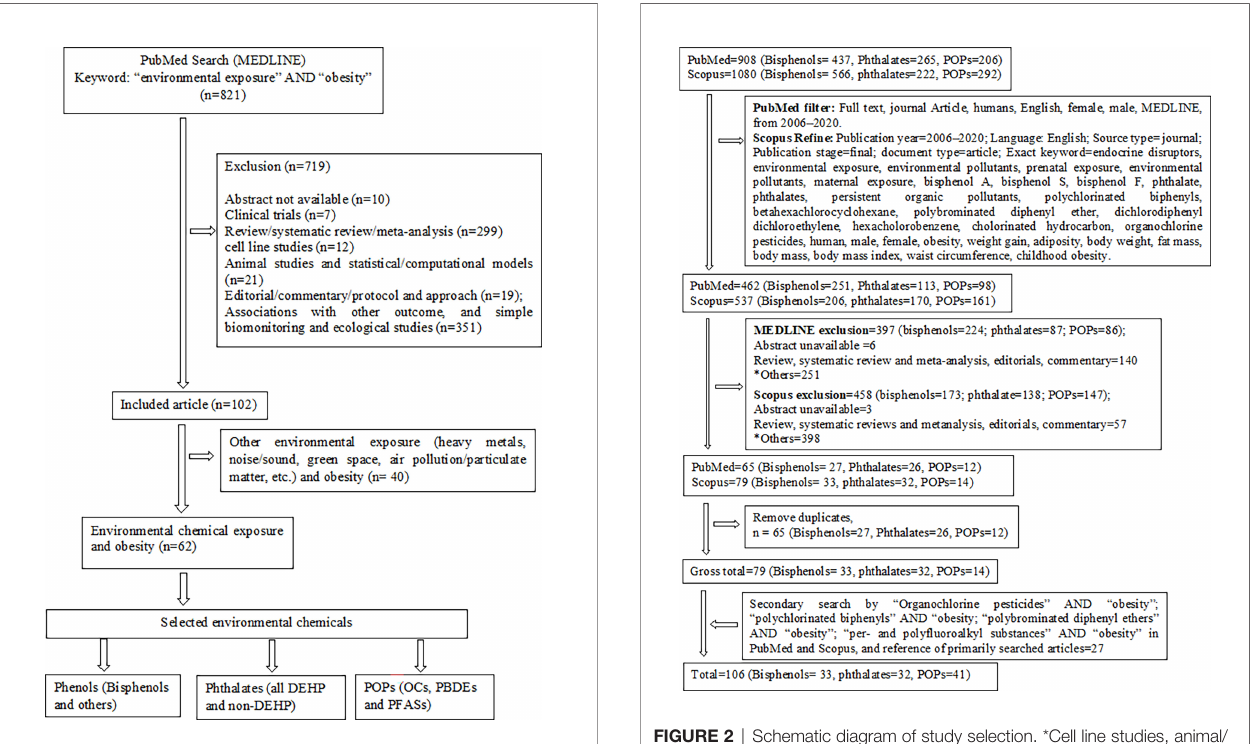
FIGURE 1 | Schematic diagram of the strategy for selection and grouping of environmental